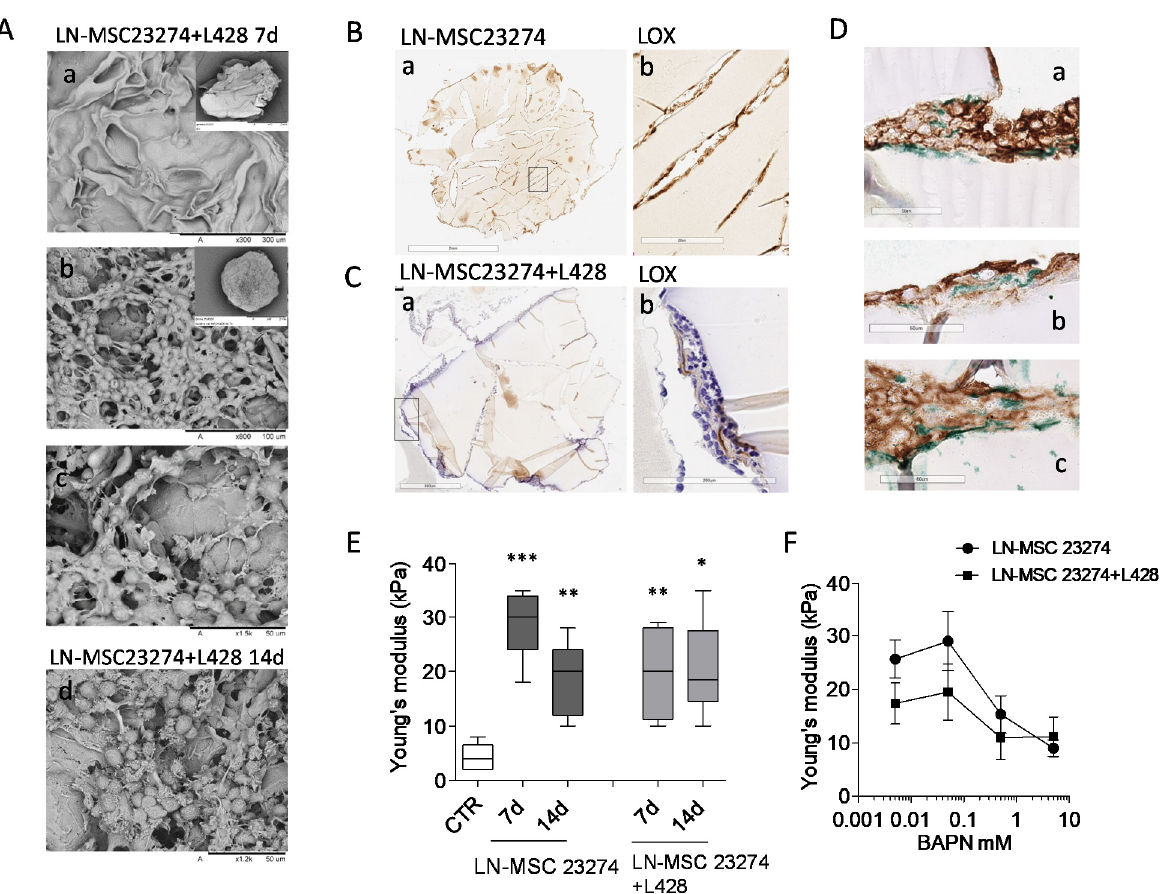
Figure 7. Involvement of LOX in GelMA stiffness. GelMA scaffolds repopulated with 2 × 10 5 LN-MSC alone or with a mix of LN-MSC and 3 × 10 5 L428 cells underwent SEM (Panel ( A ), mixture only) or IHC (Panel ( B – D )) or elastometry to determine Young’s modulus at 7 or 14 d (Panel ( E )). Parallel samples were exposed to serial dilution of the LOX inhibitor BAPN and Young’s modulus (kPa) was measured at 7 d (Panel ( F )). Panel ( A ): SEM images of empty ( a ) or repopulated (( b ) enlarged in ( c ) gelatin scaffolds at 7 d or 14 d ( d ); insets in a and b show the whole scaffold. Panel ( B , C ): sections of GelMA scaffolds repopulated with either LN-MSC ( B ) or a mixture of LN-MSC and L428 cells ( C ) stained with the anti-LOX rabbit ab174316 mAb followed by the specific GAM and DAB (in ( C ): counterstaining with HE). Subpanels b: enlargement of the rectangles in subpanels a. Panel ( D ): sections of GelMA scaffolds repopulated as in ( C ), double-stained with the anti-CD30 BerH2 mAb followed by the specific GAM and DAB (brown) and the anti-LOX rabbit ab174316 mAb followed by GAR and Vina Green Chromogen (green) in different scaffolds areas (subpanels ( a – c )). Panel ( E , F ): Young’s modulus (kPa) of GelMA scaffolds either empty (CTR in ( E )) or repopulated with LN-MSC alone or a mixture with L428 cells and cultured for 7 or 14 d (Panel ( E )) or for 7 d with the LOX inhibitor BAPN at logarithmic dilutions from 5 mM to 50 µm or 0 mM (vehicle) concentrations (Panel ( F )). * p < 0.05, ** p < 0.01, *** p < 0.001 vs. CTR. Mean ± SEM of three experiments performed in